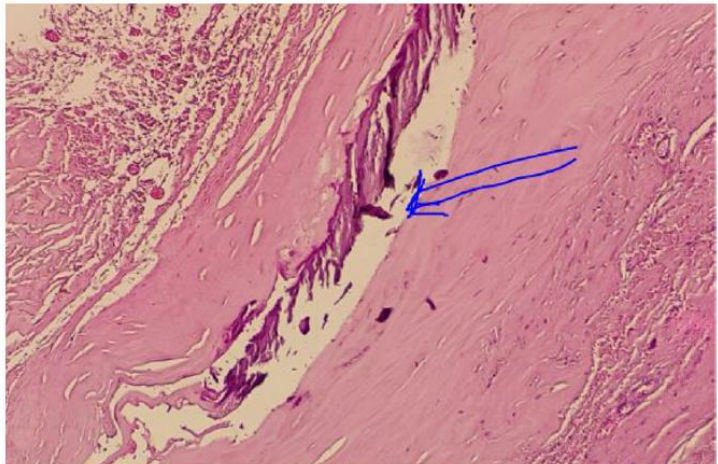
Figure 3: Pulmonary hydatic cyst under microscopic field, (Salih et al., 2016). The blue arrow shows the congested blood vessels in the pricyst with fibrofatty collagenous tissue.